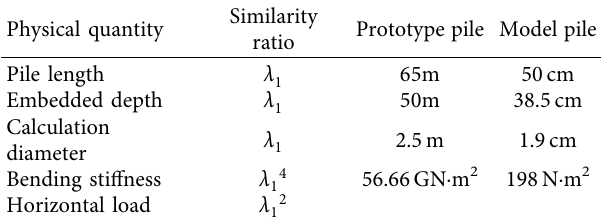
Table 1: Similarity ratio between the model pile and prototype